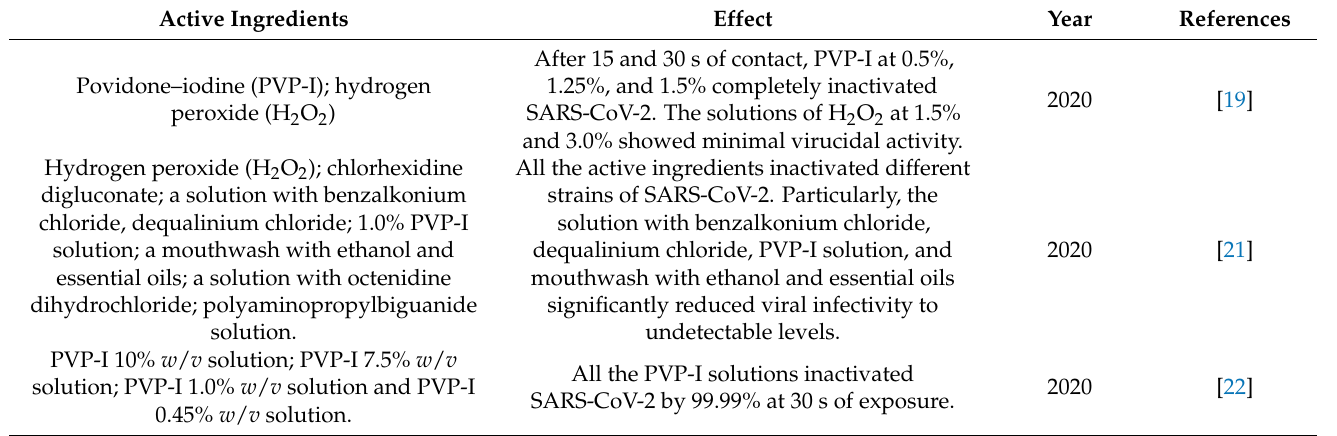
Table 1. In vitro assays of the antiviral efficacy of active ingredients against SARS-CoV-2. Active